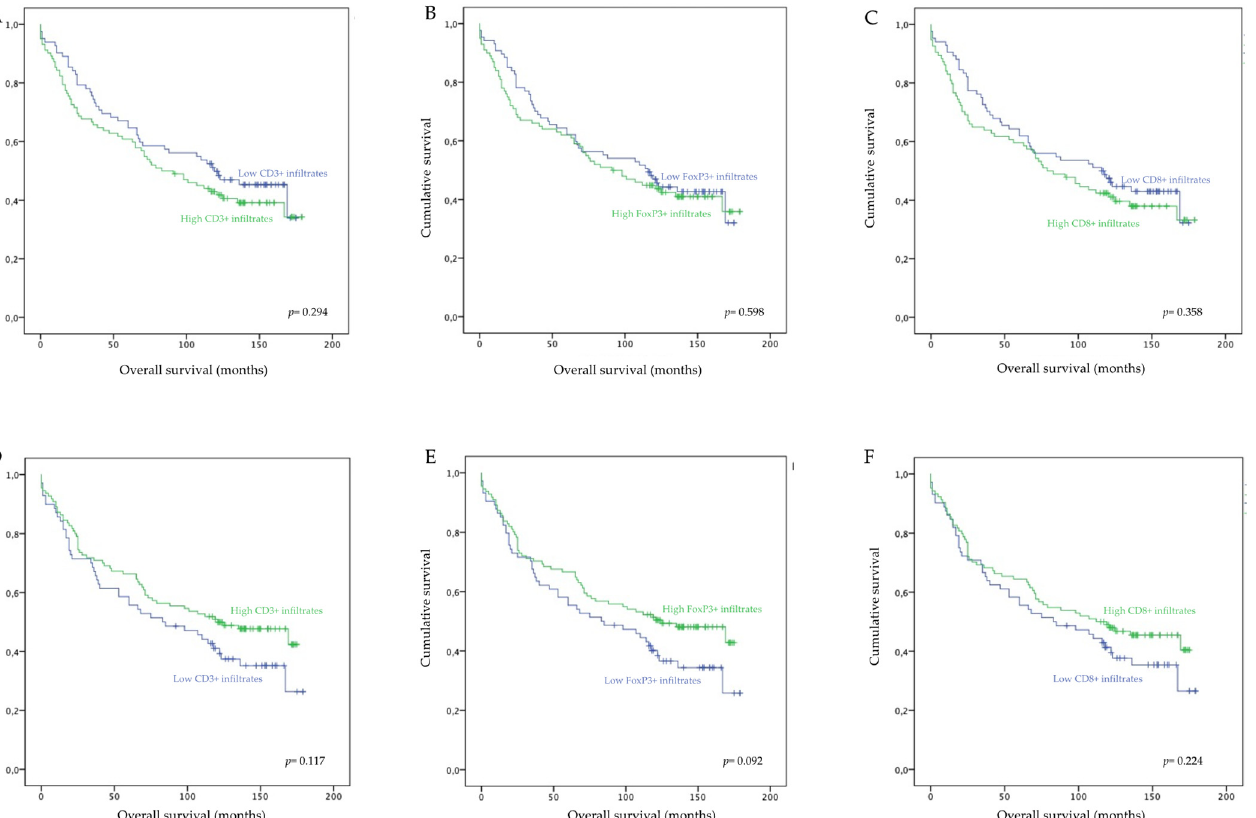
Figure 2. Overall survival of CRC patients according to low or high densities of intratumor and tumor margin infiltrating CD3 + , FoxP3 + , and CD8 + T lymphocytes. ( A ) Overall survival according to intratumor CD3 + T cell density; ( B ) Overall sur- vival according to intratumor FoxP3 + T cell density; ( C ) Overall survival according to intratumor CD8 + T cell density; ( D ) Overall survival according to tumor margin CD3 + T cell density; ( E ) Overall survival according to tumor margin FoxP3 + T cell density; ( F ) Overall survival according to intratumor CD8 + T cell density.